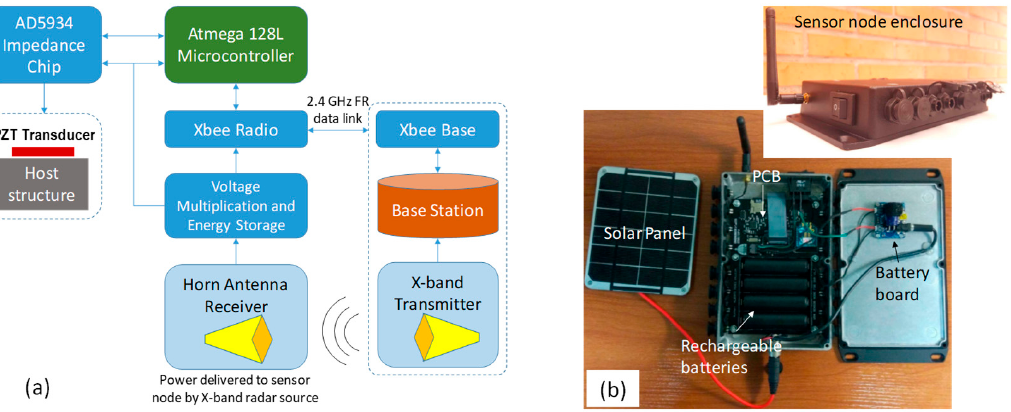
Figure 8. ( a ) Block diagram of the first wireless impedance sensor node [82]; ( b ) Prototype of a low-cost wireless impedance sensor node [28] .